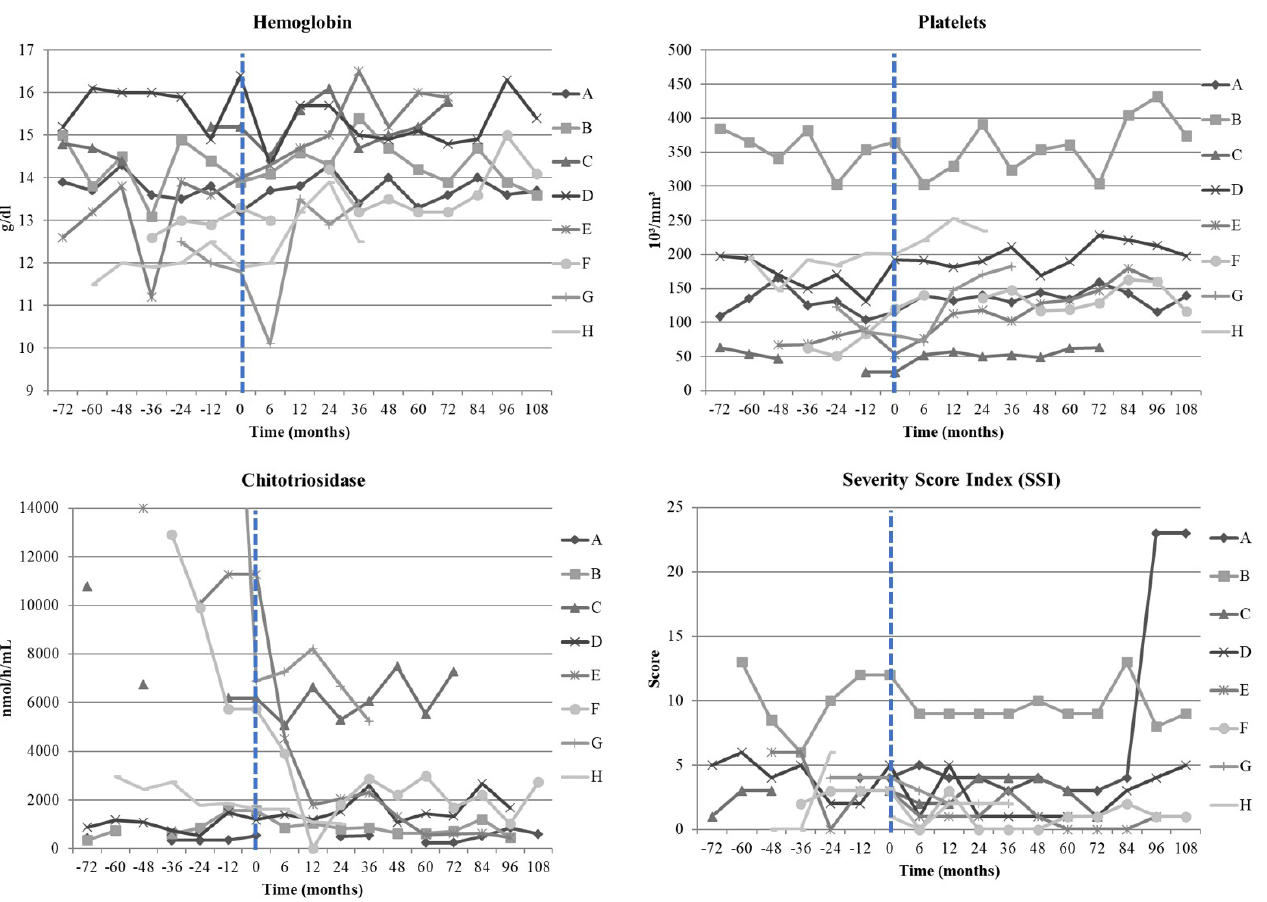
Figure 2. Disease parameters before and during ERT with taliglucerase alfa. Each line represents a different patient. Dashed blue line (Time = 0 months) marks the initiation of ERT with taliglucerase alfa. Patients G and H were